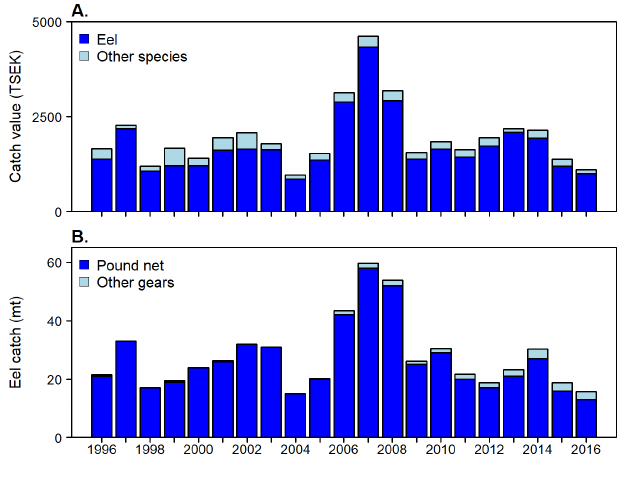
Fig. 4. Statistics showing the development of pound net fishers’ catch using all gear types. (A) Value of pound net fishers’ total catch with all gear types for eel and other species. (B) Pound net fishers’ total eel catch using pound nets and other gear